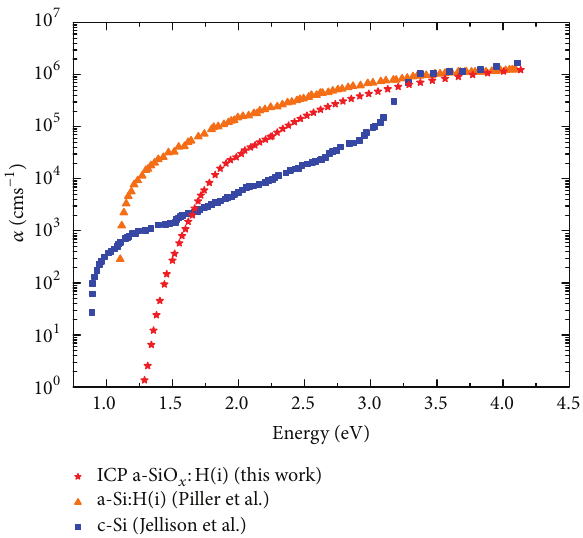
Figure 12: Absorption coefficient as a function of photon energy. For comparison, the absorption coefficients of crystalline Si (Jellison 3-1-91) [32] and a-Si:H(i) [33] are shown in the same graph. ICP a-SiO 𝑥 :H(i) film shows excellent optical properties compared to a- Si:H(i) throughout the whole wavelength